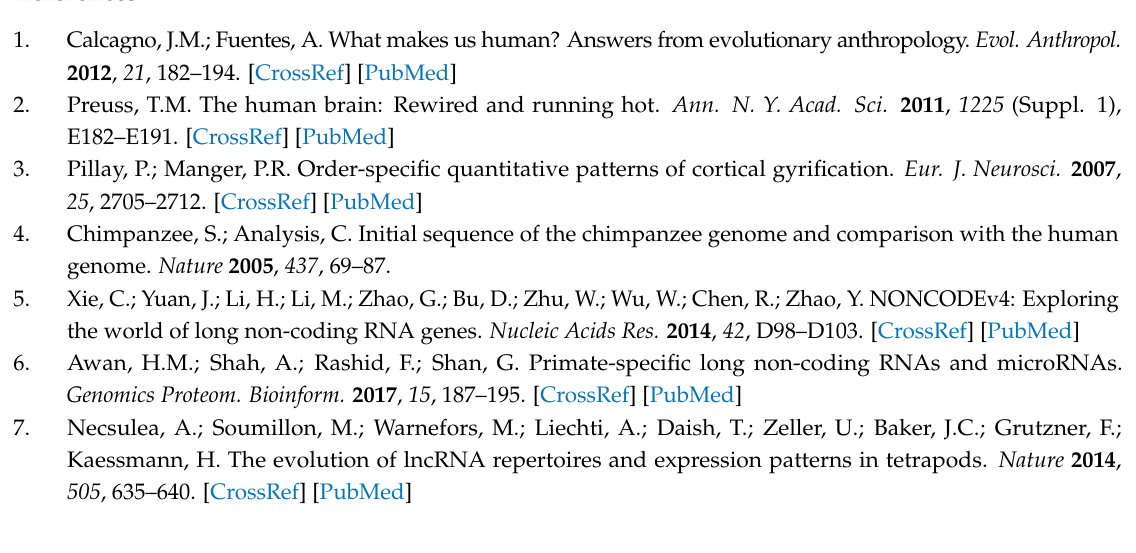
Figure S1: Correlation between the two methodological approaches for transcript abundance estimation; Figure S2: Intersection between methods in terms of transcript expression; Figure S3: Full functional network for differentially expressed genes between controls and KCl-activated neurons; Box S1: Other examples of highly expressed transcripts with previously reported roles in the brain; Table S1: Differentially expressed transcripts; Table S2: qPCR primers; Table S3: Metrics for expression of genes/transcript of interest. Acknowledgments: No applicable